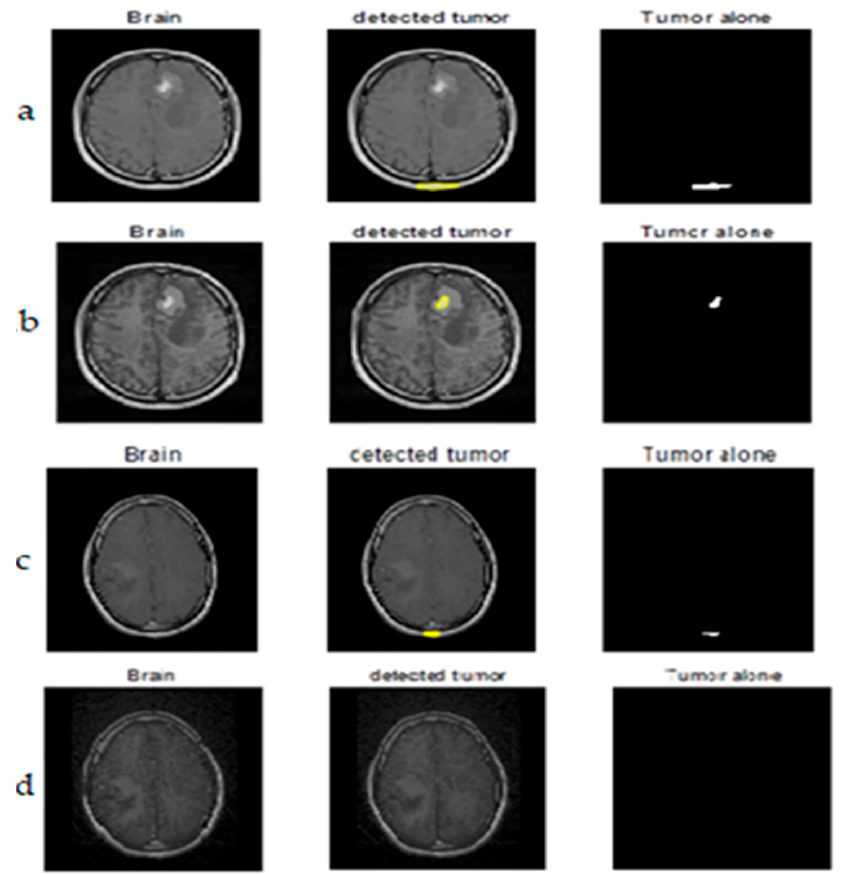
Figure 11. Tumor detection from original MRI brain images. ( a ) the first image in the is the original image, the second image is the segmentation image of the first image after preprocessing, and the third image represents detection of tumor alone. ( b – d ) rows consists of original brain images, segmented image with detected tumor, segmented tumor alone with proposed method